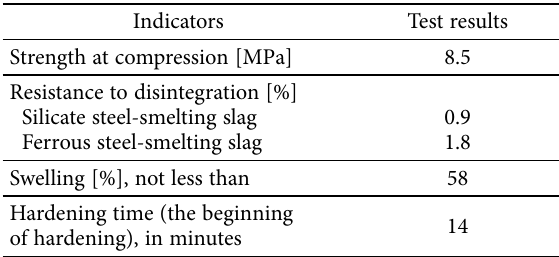
Table 4. Binding properties of electric steel-smelting slag